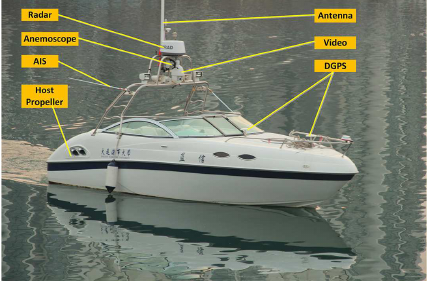
Figure 1. The Lanxin USV.